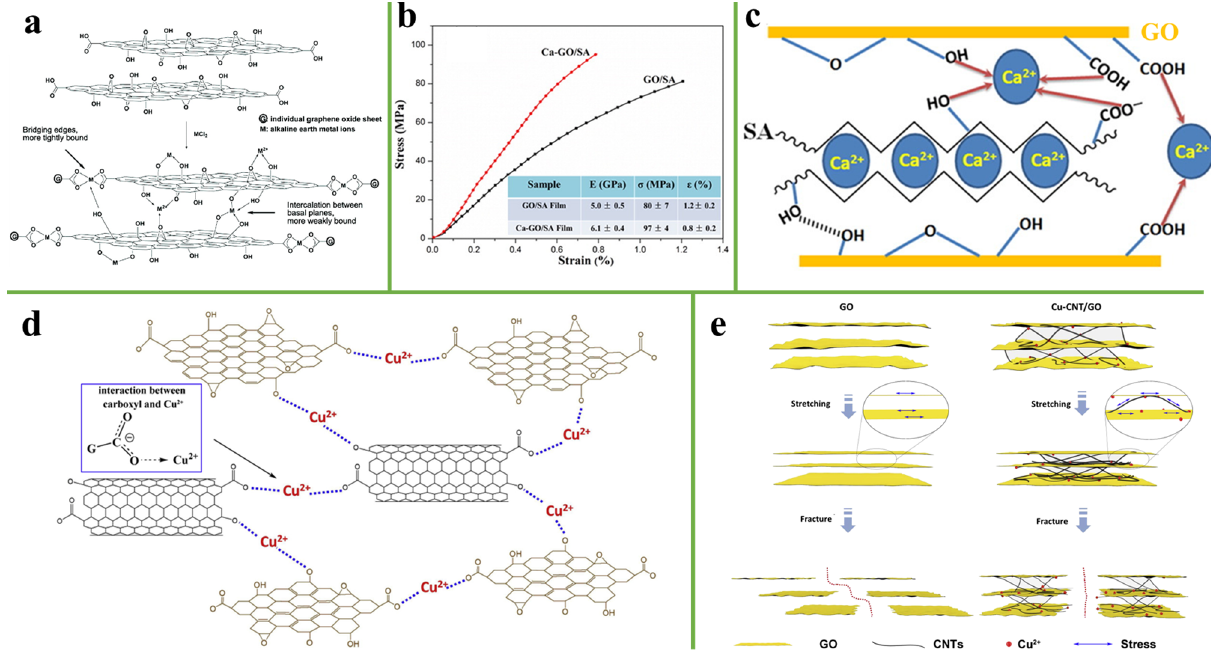
Figure 8. ( a ) Schematic model of the reaction between graphene oxide paper and MCl 2 in M-modified graphene oxide papers. Reprinted with permission from ref. [78] Copyright 2008, American Chemical Society. ( b ) Stress-strain curves of GO/SA films and Ca-GO/SA films. ( c ) Structural model for metal ion-modified nacre-mimetic film. Reprinted with permission from ref. [76] Copyright 2017, Elsevier. ( d ) Schematic illustration showing the interactions between Cu 2+ and GO or CNTs. ( e ) Schematic diagram showing the stress transfer mechanisms and fracture behaviors of GO and Cu-CNTs/GO. Reprinted with permission from ref. [79] Copyright 2017,